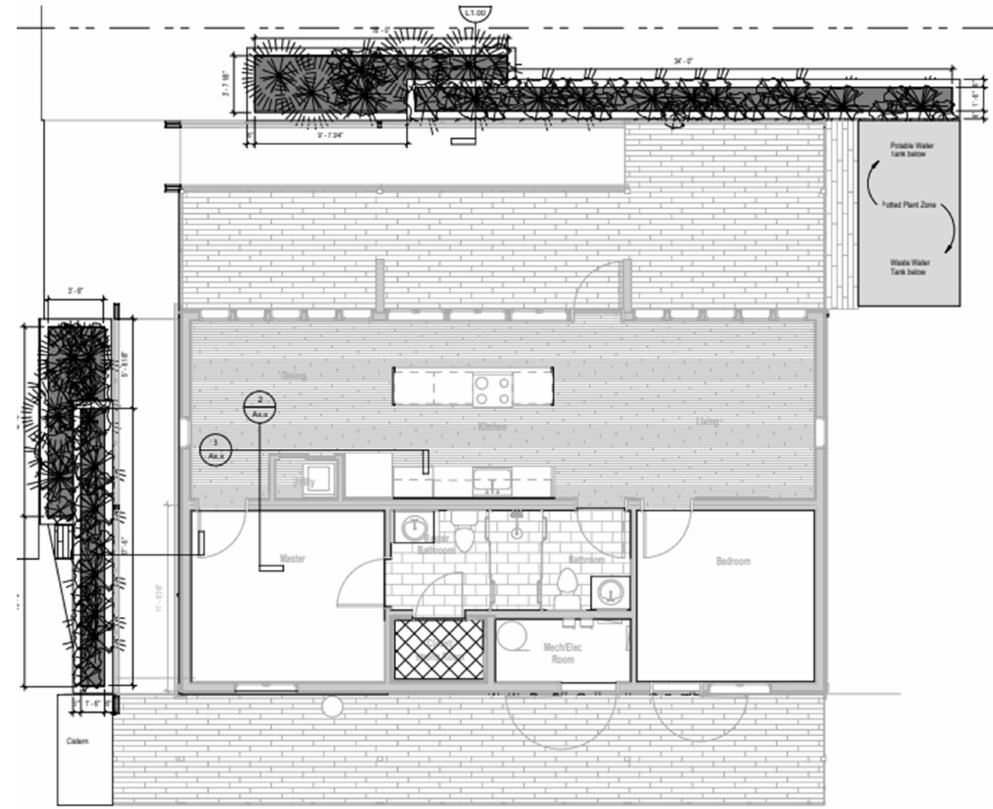
Figure 2. The plan view of the